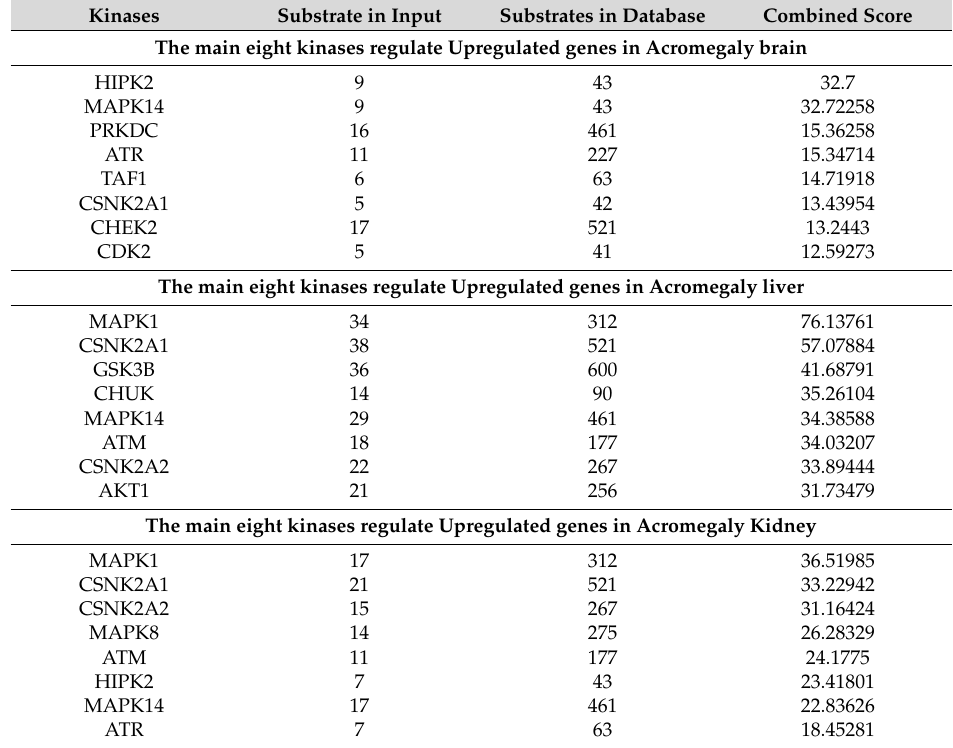
Table 1. X2K analysis of upregulated genes in acromegaly zebrafish model.